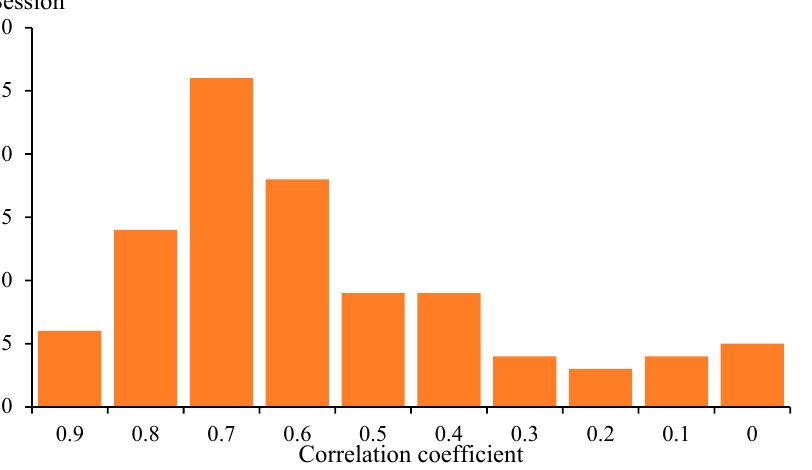
Figure 11. Distribution of the correlation coefficients between the unstructured data and the measured rainfall data.